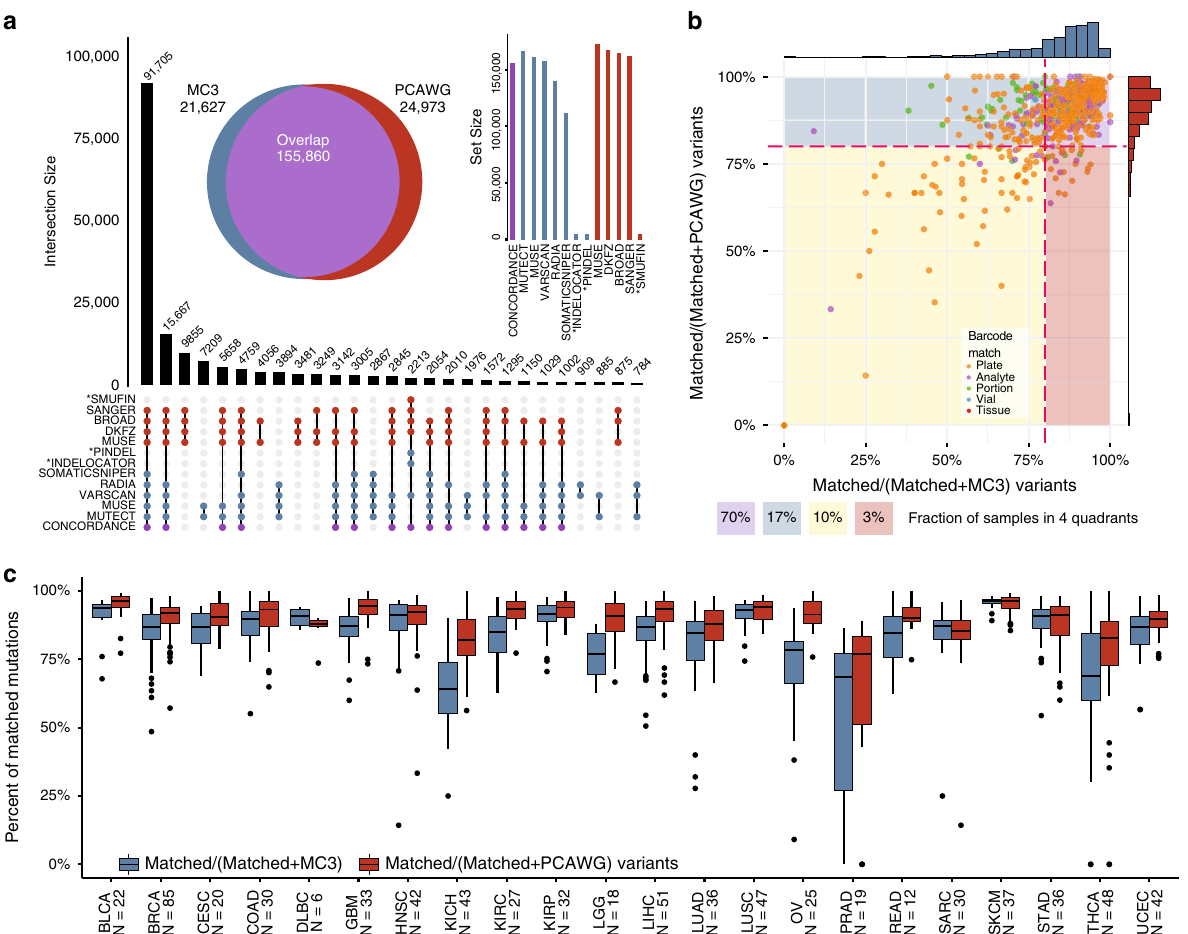
Fig. 2 Landscape of mutations overlap by caller, sample and cancer type. a UpSetR 41 plot shows the variant calling set intersection by caller. The y-axis indicates set intersection size and the x -axis uses a connected dot plot to indicate which sets are considered. Only the largest 27 intersecting sets are shown. Two insets of the UpSetR plot highlight a classic Euler diagram (left), which indicates the total number of overlapping mutations. A set-size bar chart (right) illustrates the total number of mutations considered from each caller. The concordance set indicates the agreement between WES and WGS. Indel callers are indicated with an asterisk. b A scatter plot shows the amount of concordance by sample by calculating the fraction of matched variants divided by the total number of mutations made by MC3 exome sequencing and PCAWG whole genome sequencing ( x and y -axis, respectively) below the total fraction of samples within each quadrant. Each point within the plot is related to tumor portion data collected from the TCGA barcode ID. c As shown above, this box plot separates panel b by cancer types (blue considers all MC3 variants, and red boxes indicate all PCAWG variants). Sample sizes are displayed for each cancer; points indicate samples that extend past 1.5 times the interquartile range; and horizontal bars within each box and whisker indicates median matched mutation